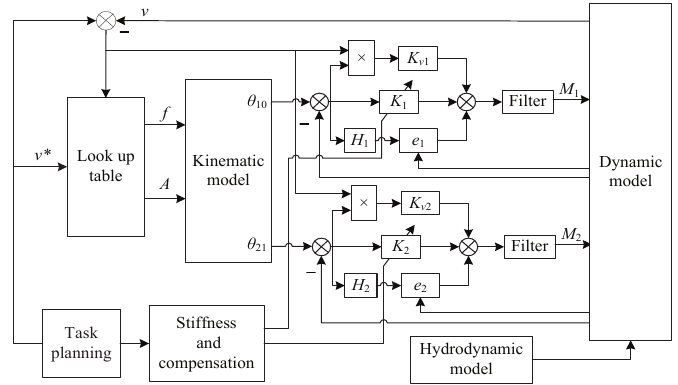
Figure 3. The closed-loop control